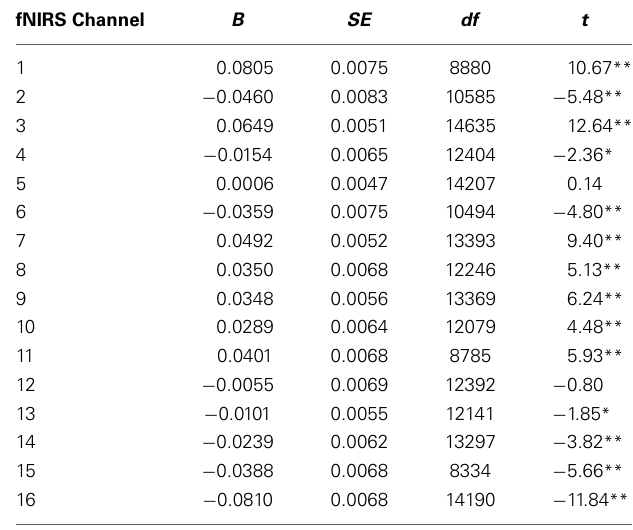
Table 6 | Multilevel analyses comparing oxy-Hb levels for participants who did not meet the 90% accuracy threshold ( N =